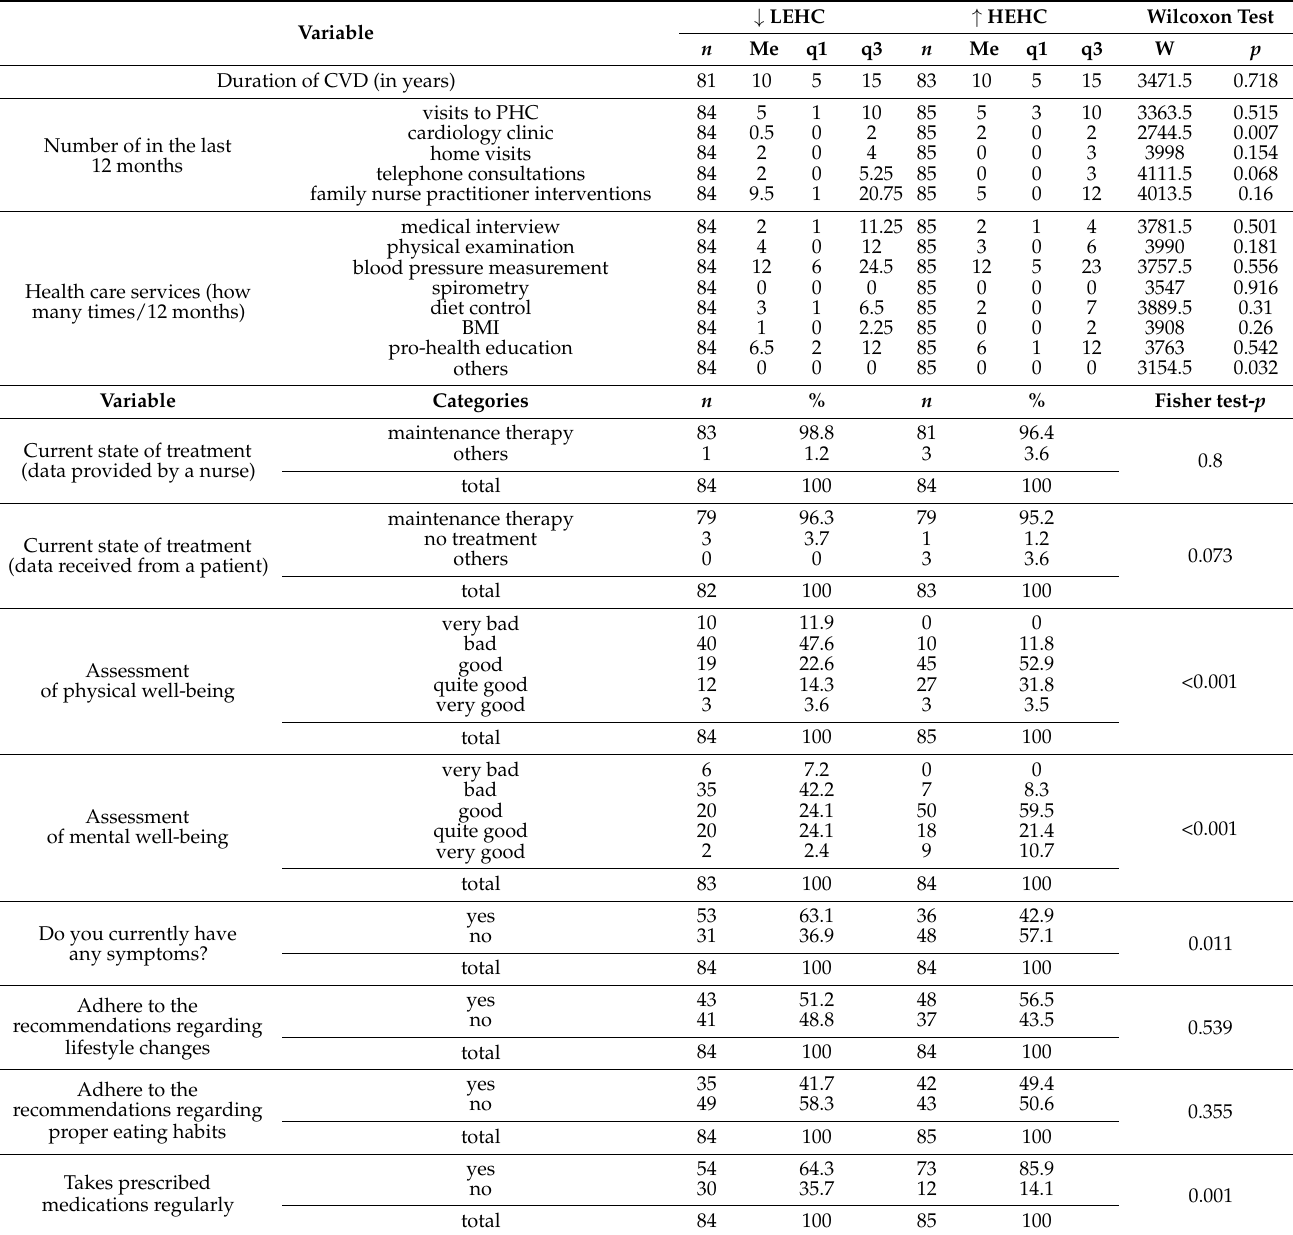
Table 1. Clinical data of CVD patients with LEHC ( n = 84 *) and HEHC ( n = 85